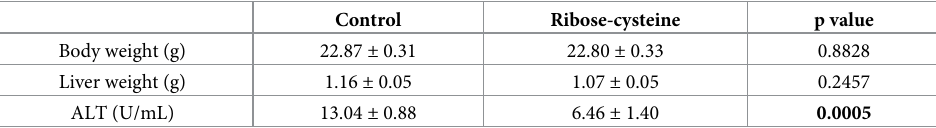
Table 1. Body weight, liver weight and ALT measurements after 8 weeks of ribose-cysteine